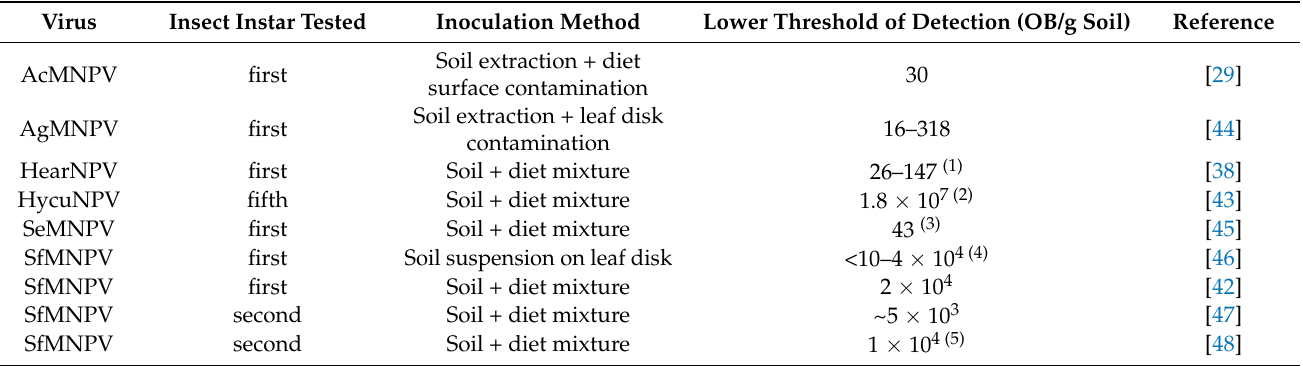
Table 1. Studies on the quantification of baculovirus occlusion bodies (OBs) in soil using insect bioassay